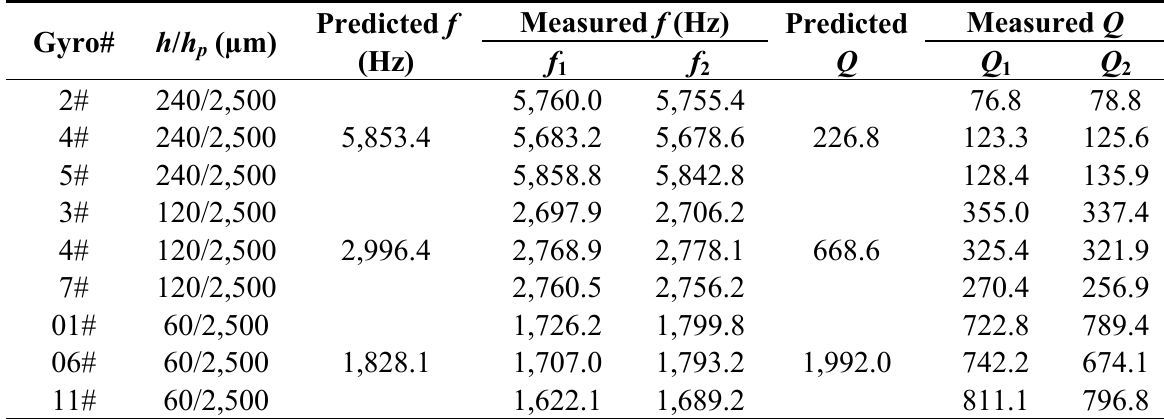
Table 2. The predicted f and Q , measured f and Q for rocking mass gyroscope